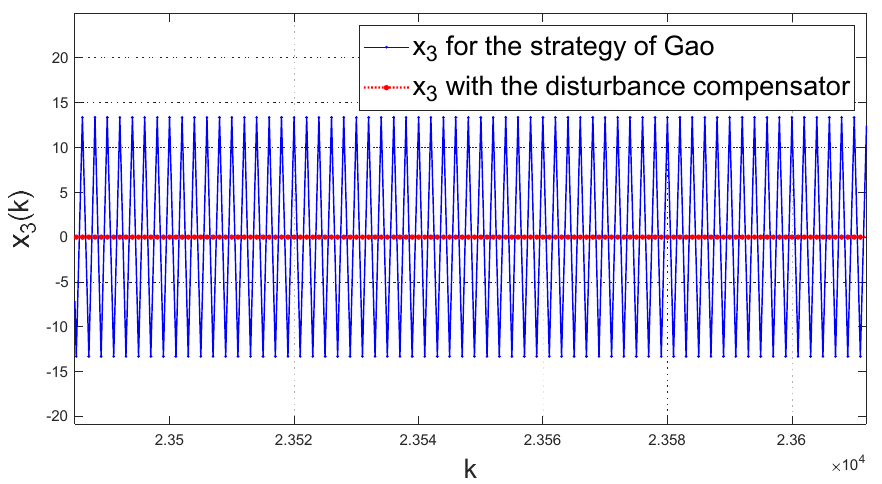
Figure 13. x 3 ( k ) for both control strategies in the sliding phase.